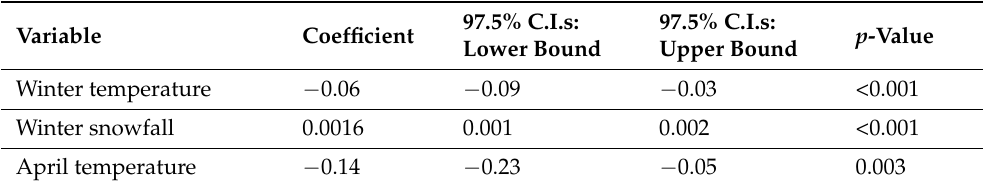
Table 5. Significant independent variables in linear regression model predicting mean snow cover value. Model R 2 = 0.58. C.I.s indicate Confidence Intervals. 97.5% C.I.s: Variable Coefficient